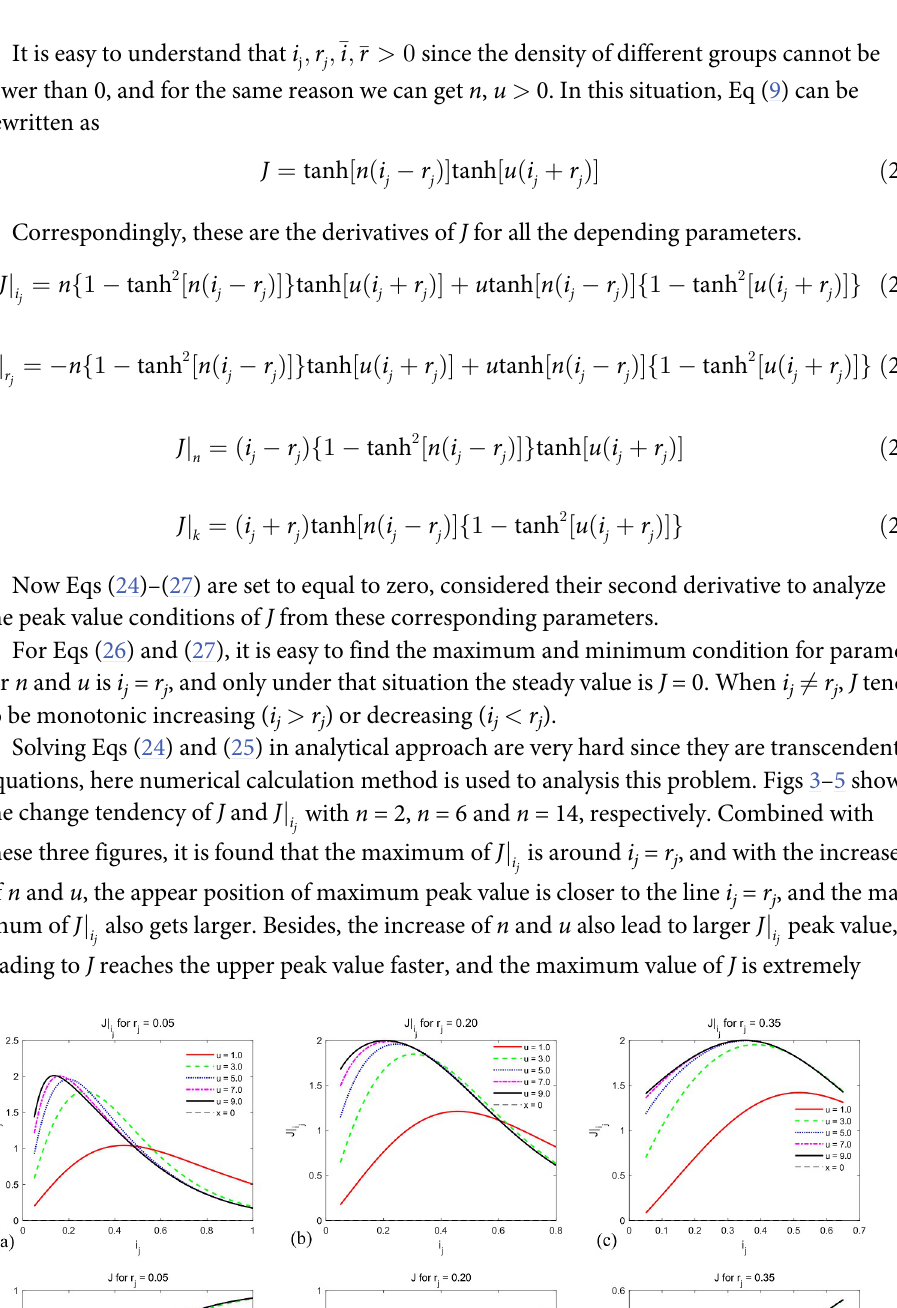
Fig 3. The change tendency of J and J j and u with r = 0.05, 0.20, 0.35, respectively. While (d)–(f) shows the change of J by different i j 0.20, 0.35,